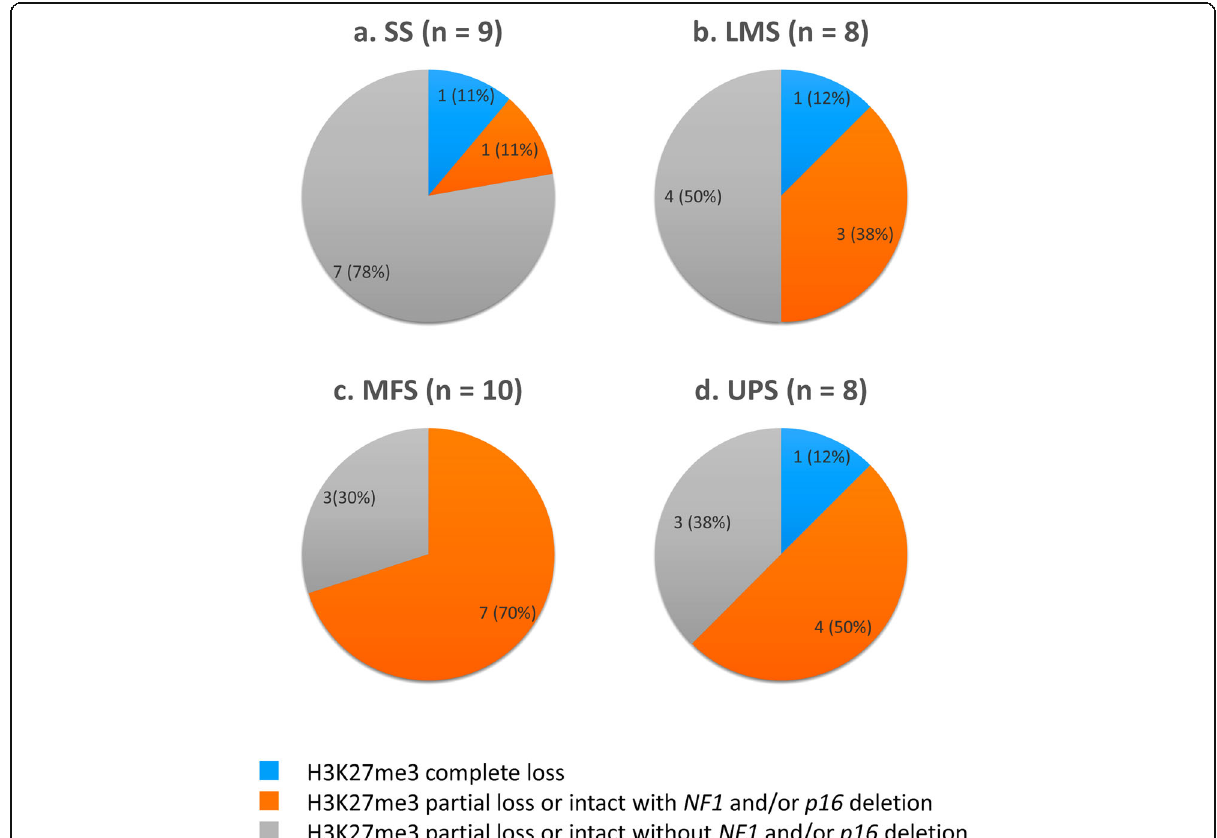
Fig. 3 Combination of immunohistochemistry for histone 3 trimethylated on lysine 27 (H3K27me3) and fluorescence in situ hybridization for neurofibromatosis 1 ( NF1 ) and p16 deletion in non-malignant peripheral nerve sheath tumors. a . Status of H3K27me3 loss and NF1 and/or p16 deletion in synovial sarcoma (SS) cases. A minority of SS cases showed H3K27me3 complete loss and H3K27me3 partial loss or intact with NF1 and/or p16 deletion. b . Status of H3K27me3 loss and NF1 and/or p16 deletion in leiomyosarcoma (LMS) cases. c . Status of H3K27me3 loss and NF1 and/or p16 deletion in myxofibrosarcoma (MFS) cases. A majority of MFS cases showed H3K27me3 partial loss or intact with NF1 and/or p16